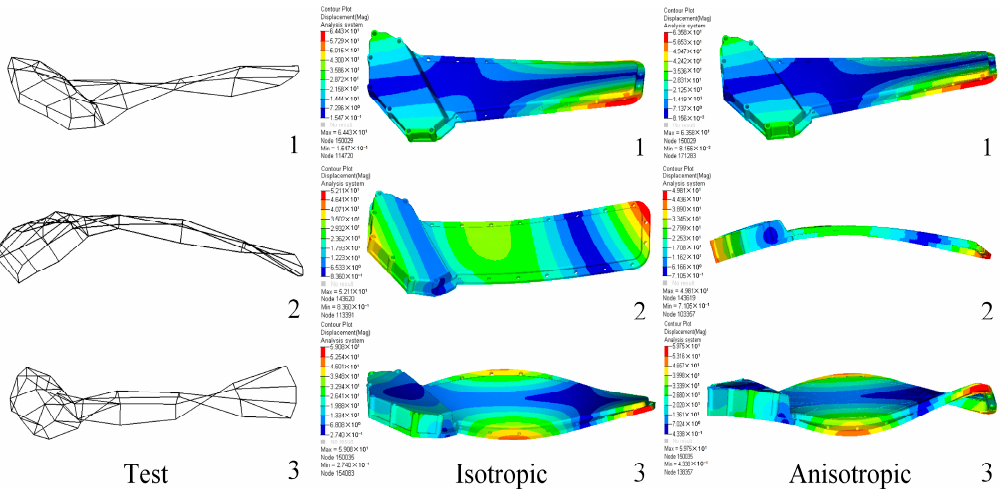
Table 3. Comparisons of modal frequencies of the oil cooler cover between tested and simulated results.